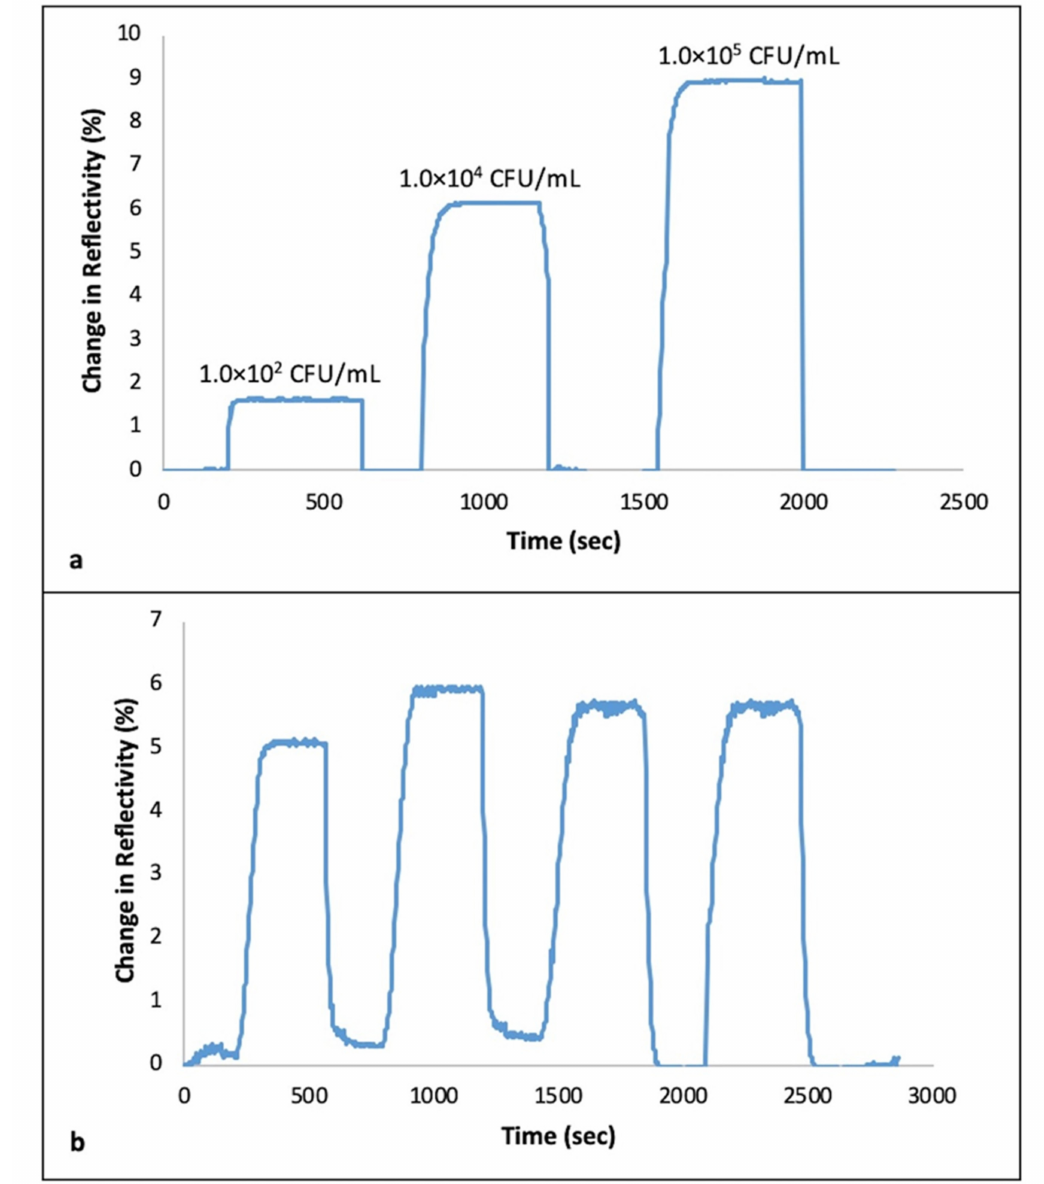
Figure 6. ( a ) Real-time responses of S. aureus -imprinted SPR sensor chip showing the sequential injection of S. aureus -spiked river milk sample, sample 1: 1.0 × 10 2 CFU/mL, sample 2: 1.0 × 10 4 CFU/mL, sample 3: 1.0 × 10 5 CFU/mL ( b ) Reusability of S. aureus -imprinted SPR sensor chip obtained by repeated four equilibration-injection-regeneration